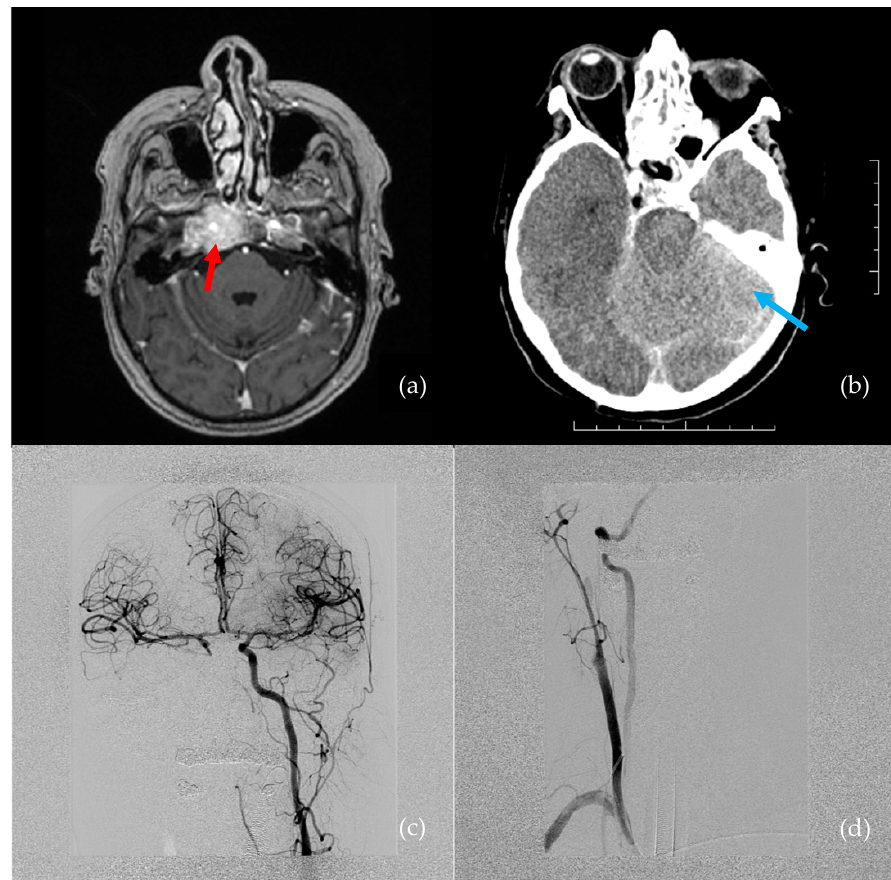
Figure 1. Pre- and postoperative images show iatrogenic injury to the internal carotid artery (ICA). ( a ) Preoperative MRI: tumor involving the right cavernous sinus, encircling the ICA (indicated by red arrow). ( b ) Postoperative brain CT: ischemia and edema in the right hemisphere (indicated by blue arrow). ( c ) Selective left ICA angiogram: good collateral flow through the anterior communicating artery to the right anterior cerebral artery and middle cerebral artery territory. ( d ) Selective right ICA angiogram: occlusion of the cavernous segment of the right ICA.